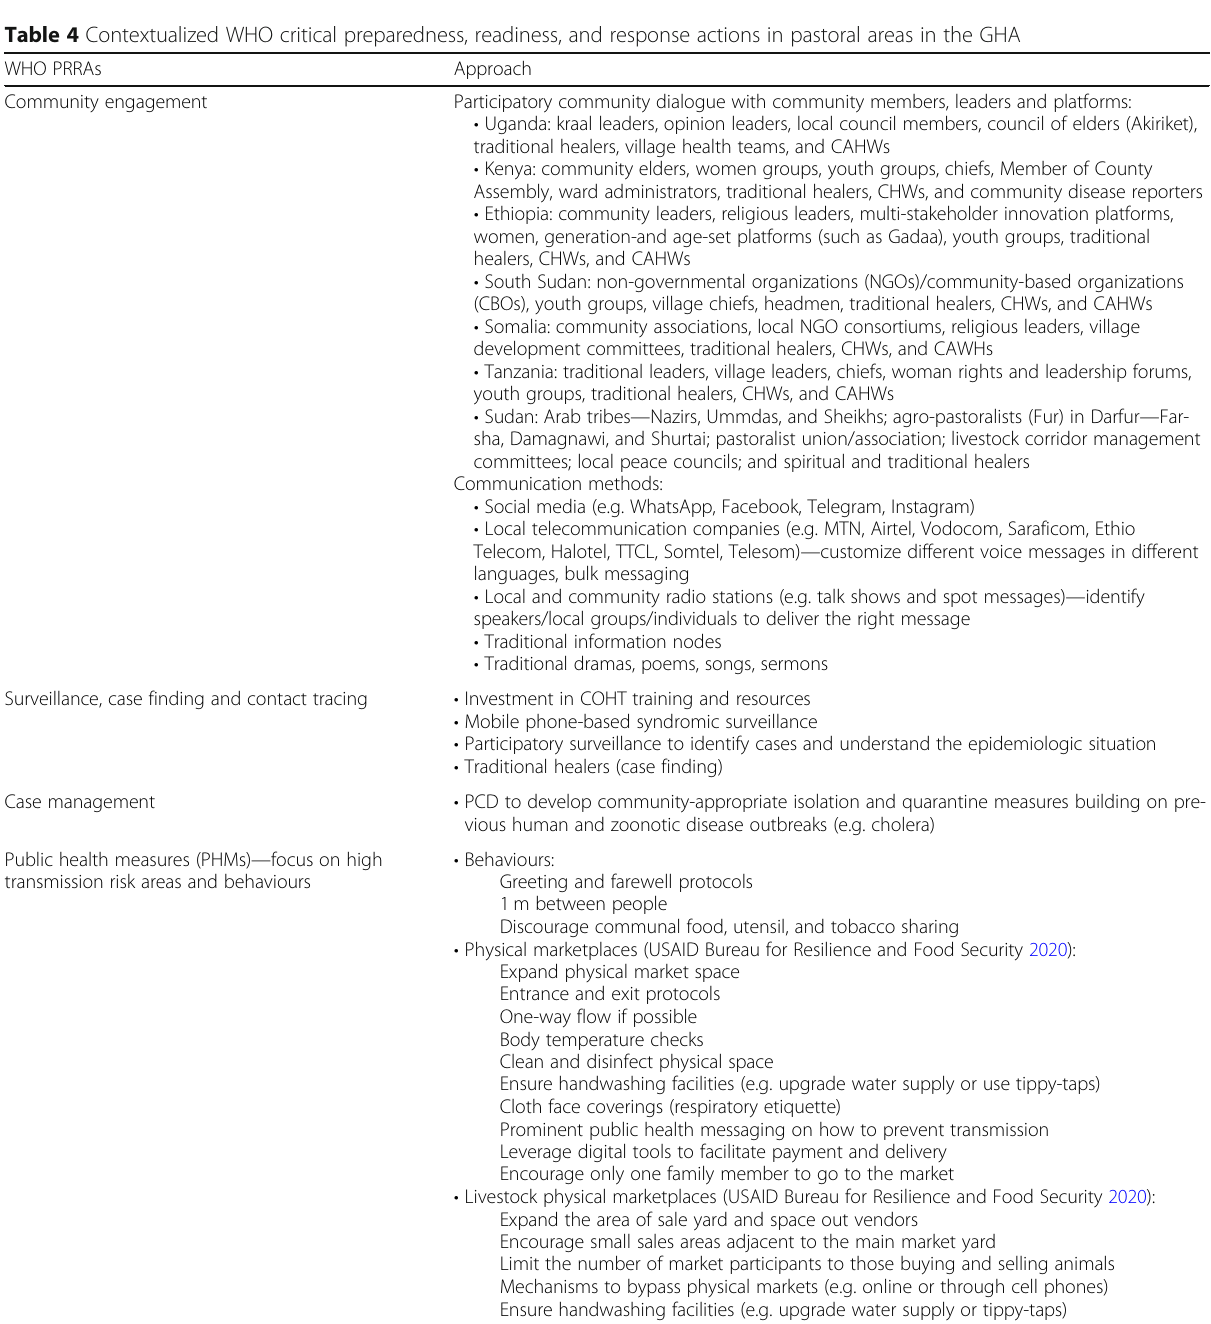
Table 4 Contextualized WHO critical preparedness, readiness, and response actions in pastoral areas in the GHA WHO